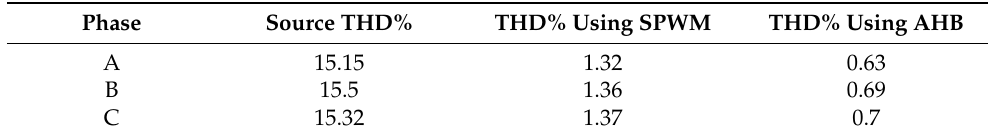
Table 4. The voltage THD for the case of voltage